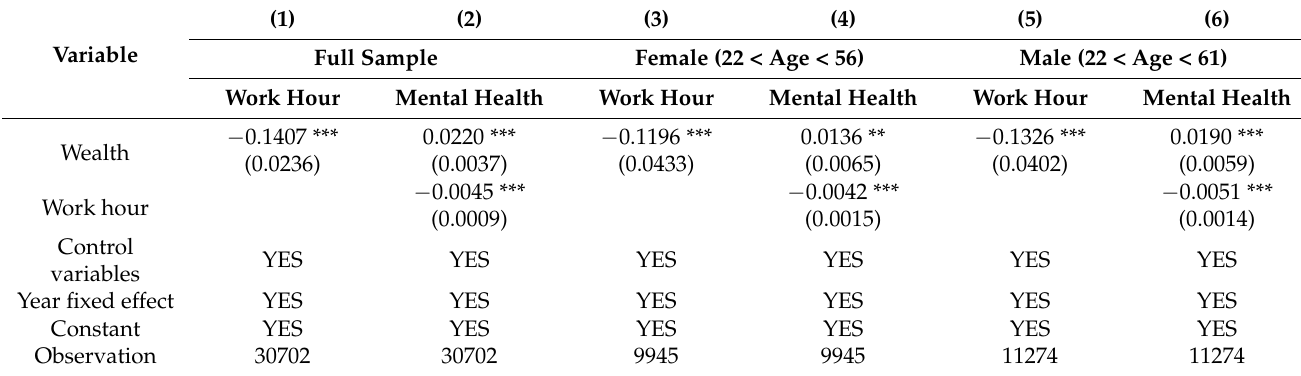
Table 8. Mediating effect of resident’s labor